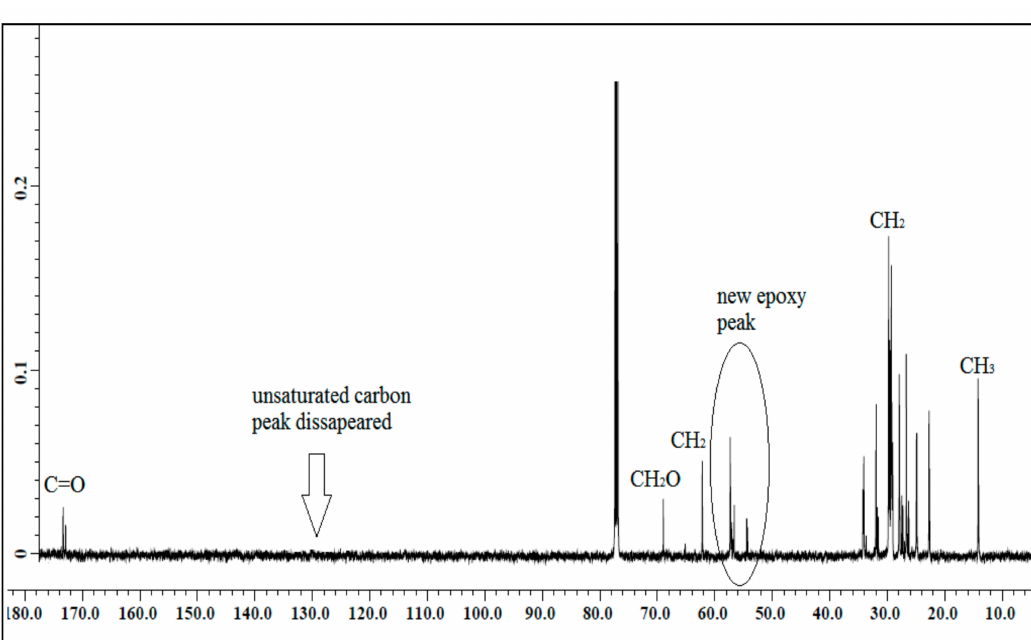
Figure 2. 13 C NMR spectrum of epoxidized jatropha